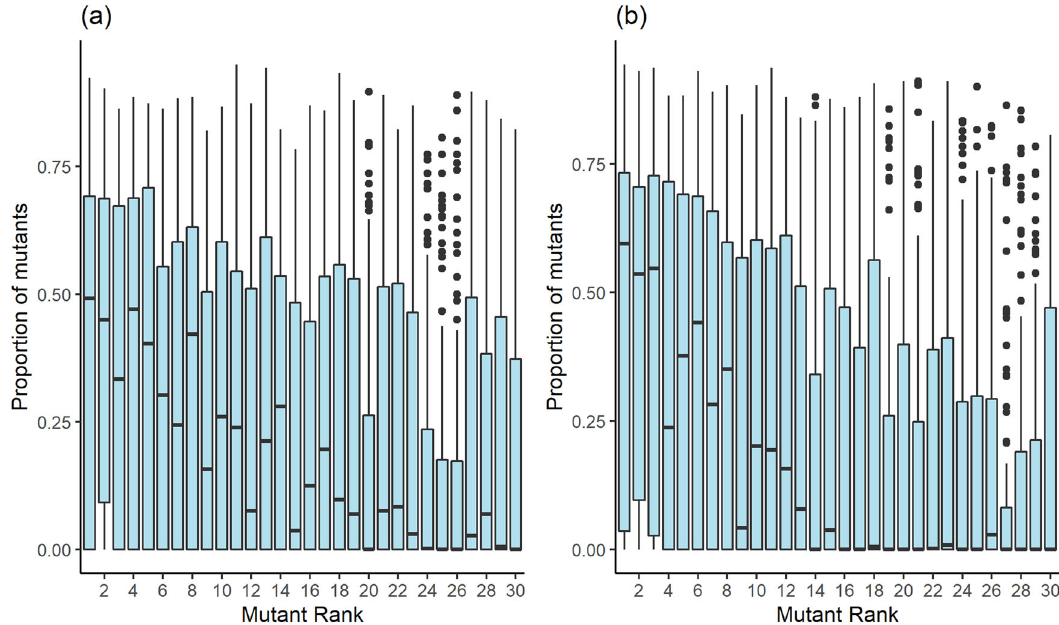
Fig. 2 Boxplots of total mutants ’ proportion in fi nal population as a function of original mutant female ’ s rank. a Scenario III — male ’ s rank attained by order of joining clan; b Scenario IV — male ’ s rank depends on mother ’ s rank. In these two scenarios male ’ s rank affects both death and reproduction probabilities. Rank 1 corresponds to highest rank. Population size in all simulations is 300. Each simulation consists of 3000 iterations. 3000 simulations were run for each scenario, 100 simulations for each female ’ s rank. Boxplots show the interquartile range (box), median (black line), median± 1.5 IQR (error bars), and outliers